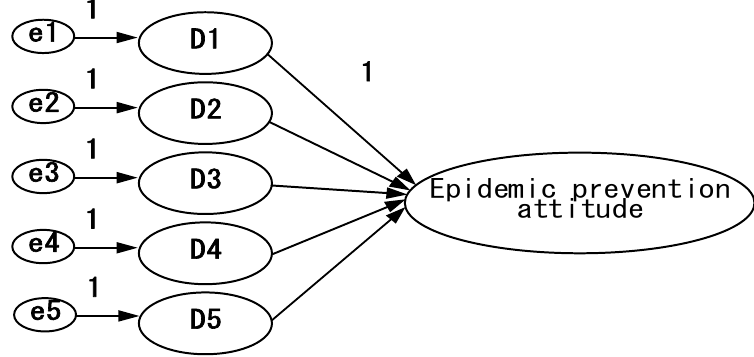
Figure 4. Epidemic prevention attitude model—confirmatory factor analysis framework.